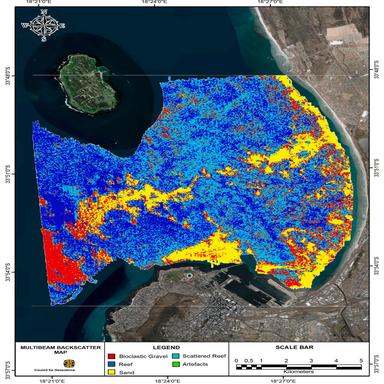
Seafloor substrate classification map using k-means clustering and feature agglomeration methods from multibeam backscatter data in Table Bay.